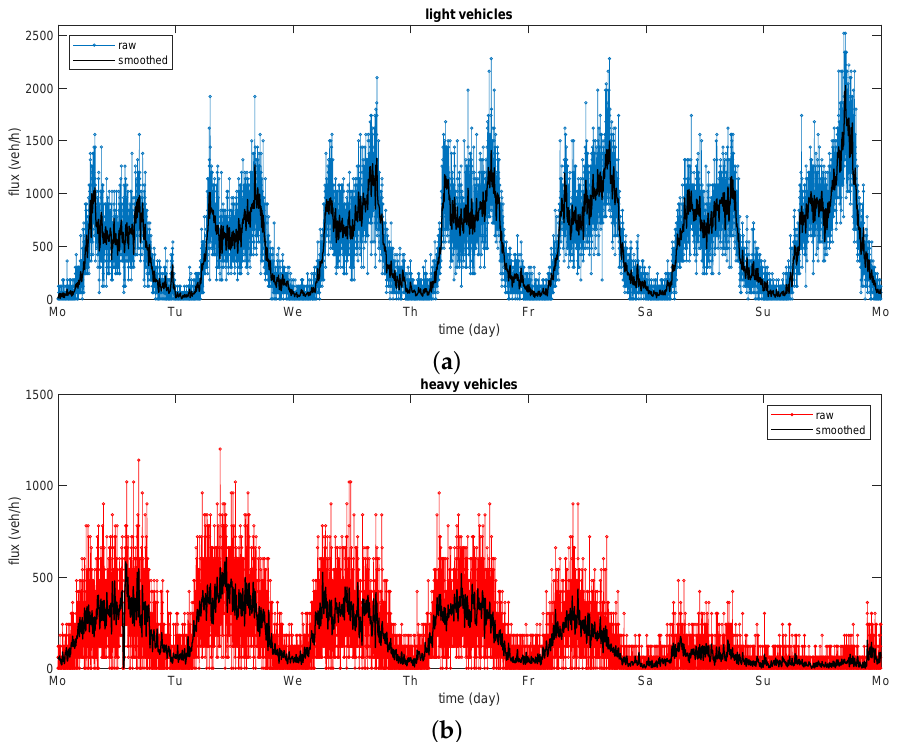
Figure 2. Typical weekly (from Monday to Sunday) flux data on the A4 motorway of ( a ) light and ( b ) heavy vehicles collected on March 2019 near Redipuglia. Smoothed data are plotted in black. Note the flux drop of cars in the middle of the day and of trucks on the weekend.